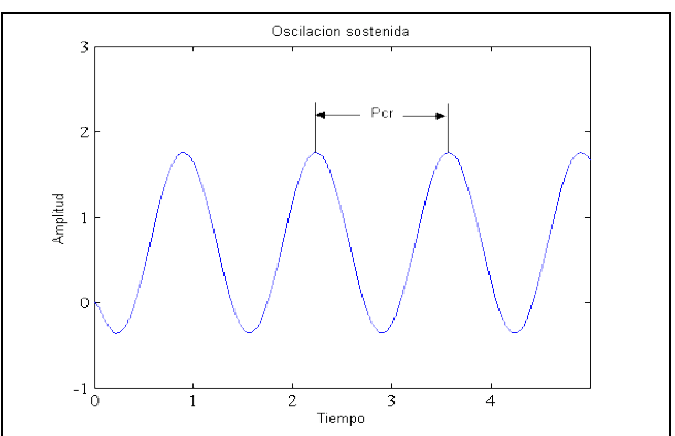
. 𝒄 𝒓 de acuerdo con las Tablas 2 , 𝑇 , 𝑇 𝑝 𝑖 𝑑